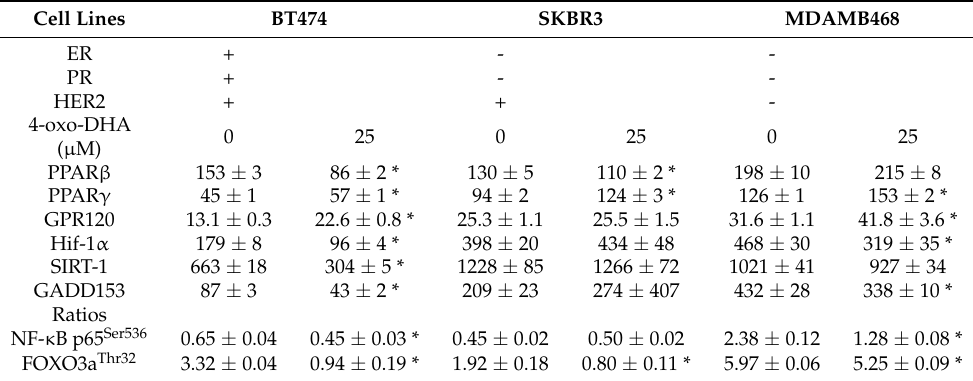
Table 2. Effect of 4-oxo-DHA on Cell Transcription